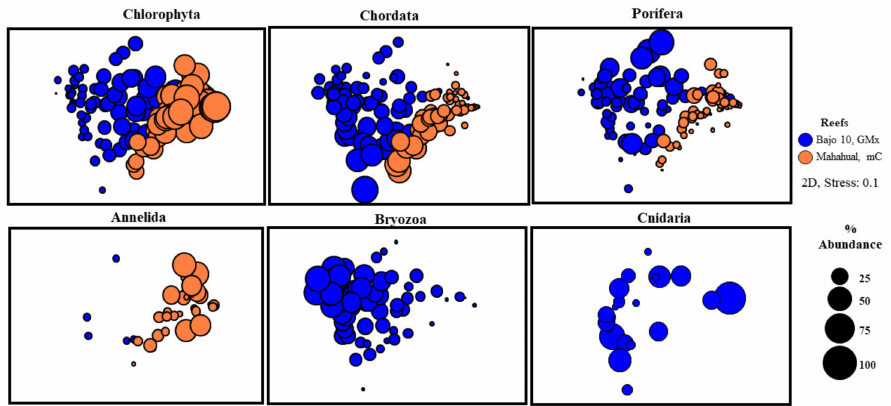
Figure 4. Patterns of Bray–Curtis similarities between plate-sides of each ARMS in both reefs, consid- ering the relative abundance (coverage) of six phyla, represented in a nonmetric multidimensional scaling ordination (nMDS). The size of each symbol represents the relative abundance of the